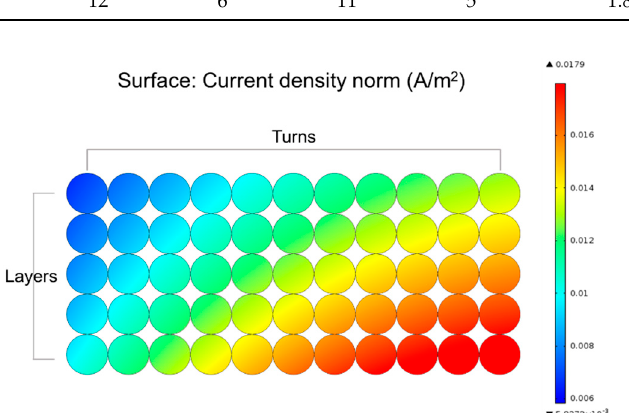
Figure 6. Cross section of surface current density of implant coil in COMSOL simulation when the transfer distance is 5 mm.